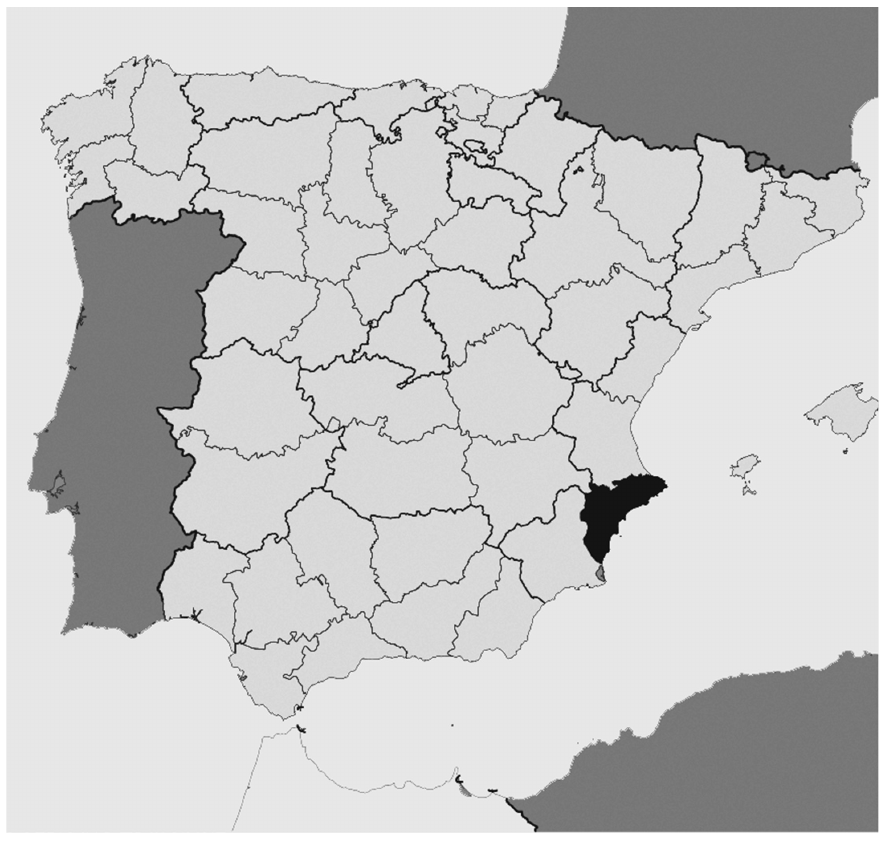
Figure 1. Province of Alicante localization (source: adapted from Wikipedia